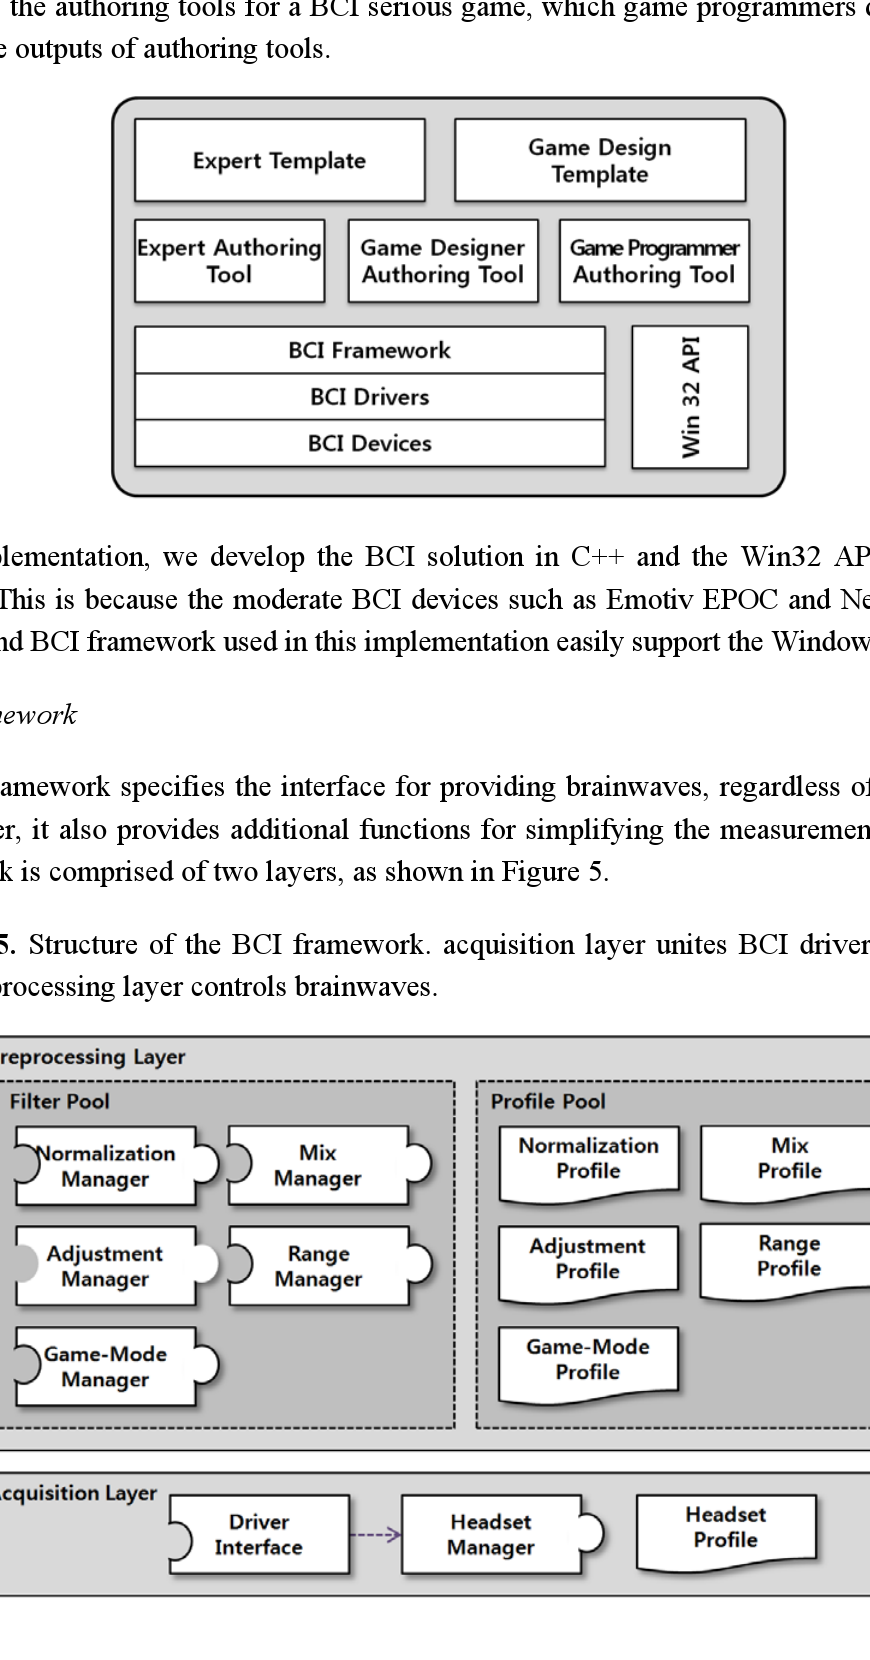
Figure 4. BCI solution architecture of hybrid neurofeedback model. The BCI solution